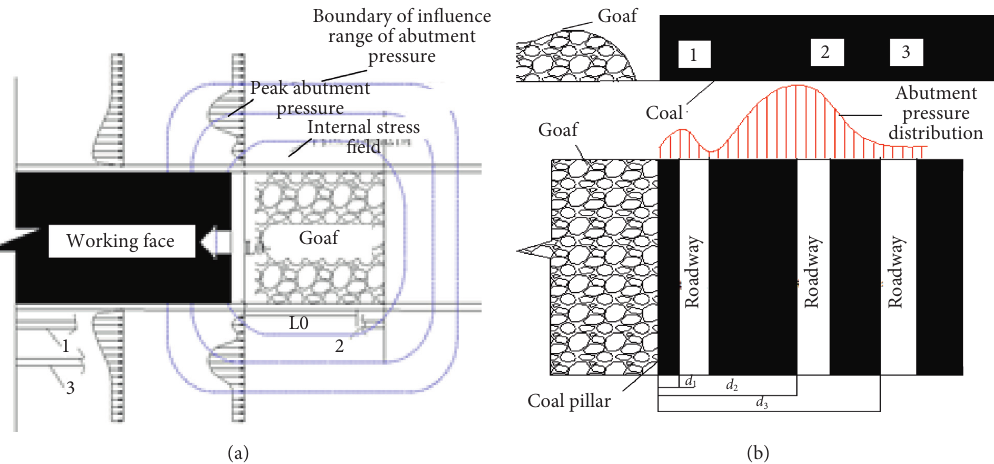
Figure 2: Relationship between the movement of the surrounding rock of the roadway and the abutment pressure distribution. (a) Plan and (b)